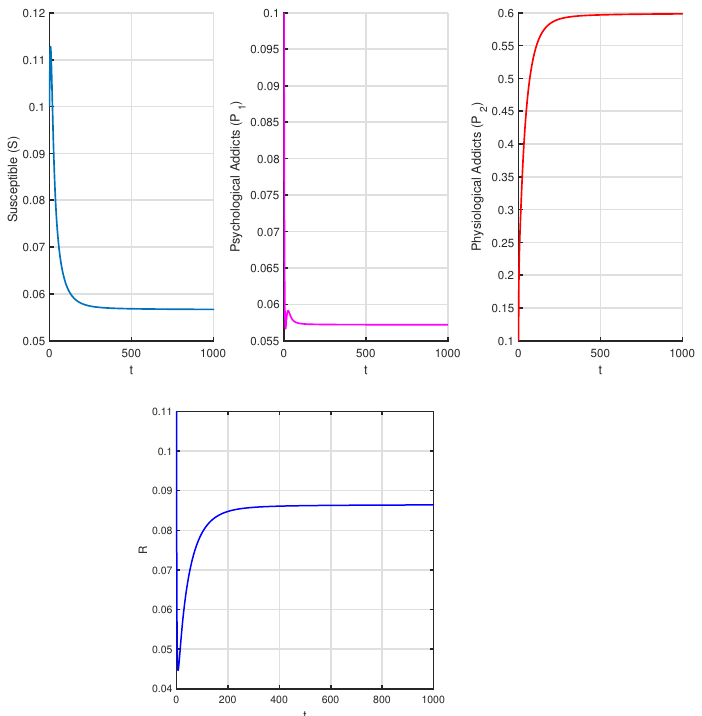
Figure 4. Time series of system (3) corresponds to Table 4 when E 1 = ( 0.0567,0.0572,0.5984,0.0864 ) and R 0 = 2.2154.